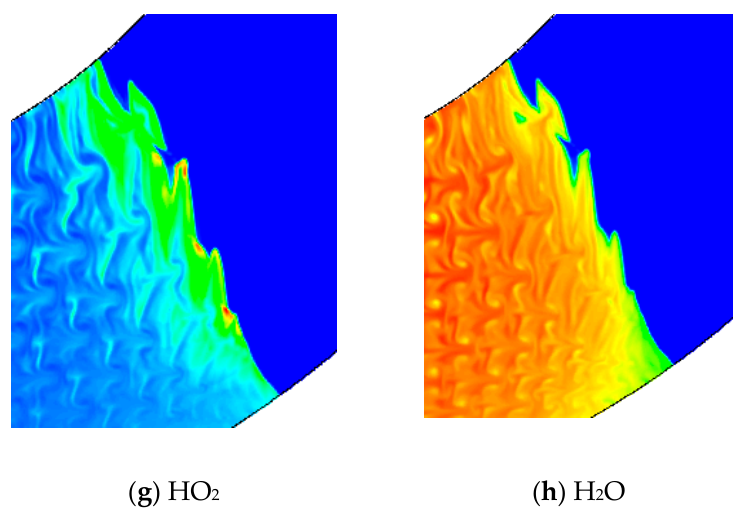
Figure 12. Comparison of different chemical components in 60° bend.